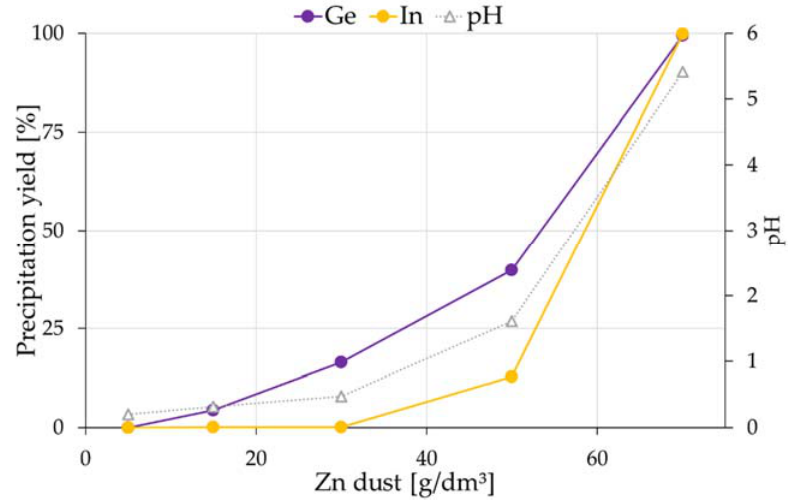
Figure 4. Influence of Zn dust amount on precipitation yields of Ge and In, and final pH (75 °C, 2 h, detinned solution).